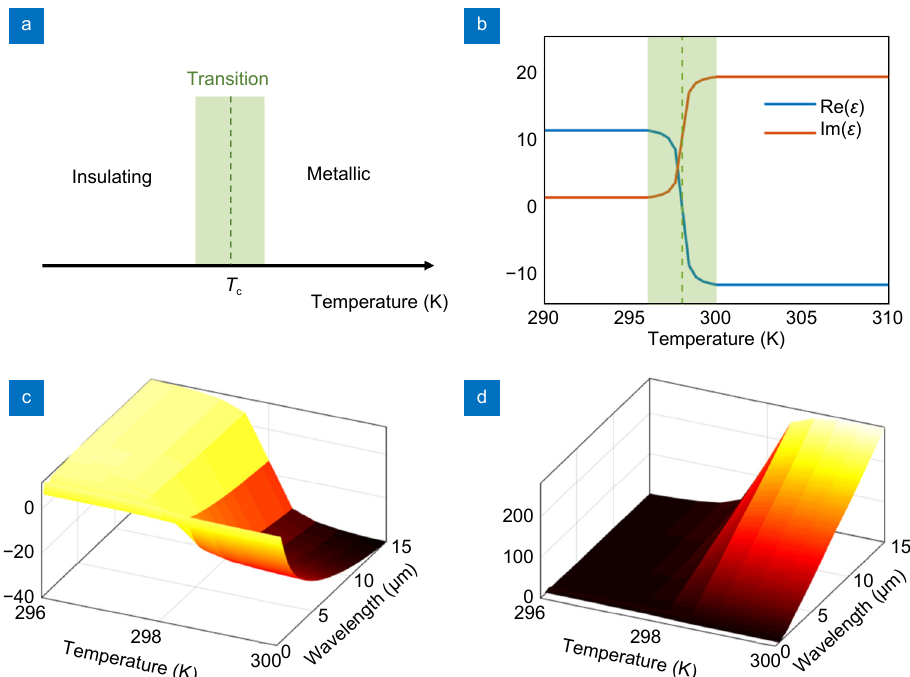
Fig. 1 | Temperature-dependent material responses of VO 2 . ( a ) Schematic of temperature-dependent phase. ( b ) Permittivity at 2 μm when T c = 298 K. Shaded area represents transition regime. ( c ) Real and ( d ) imaginary part of permittivity in transition